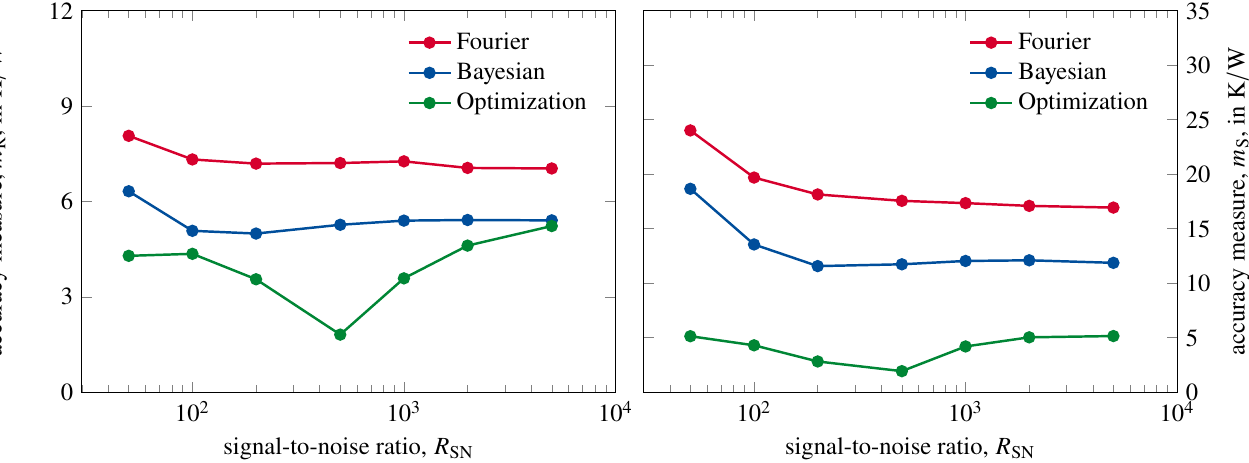
Figure 6. Accuracy of the median integrated time constant spectrum and median structure function for Fourier deconvolu- tion, using a Hann filter, Bayesian deconvolution and the optimization-based network identification using the Powell solver, calculated from 2000 noise realizations for structure